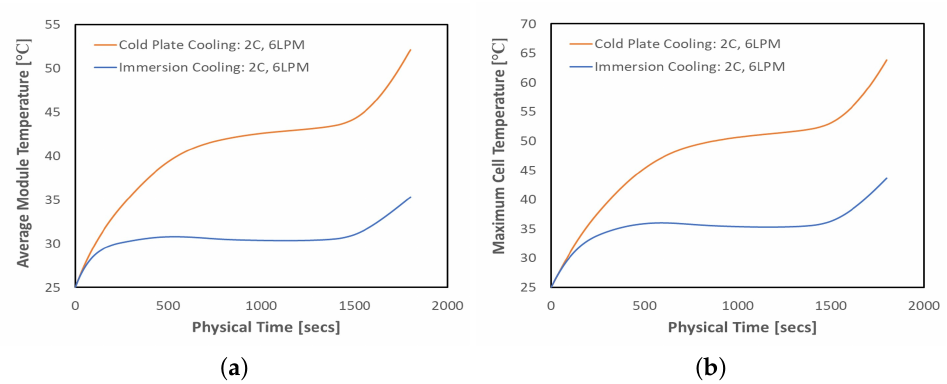
Figure 8. Transient behavior of ( a ) average and ( b ) maximum temperatures of all the cells within the battery module.